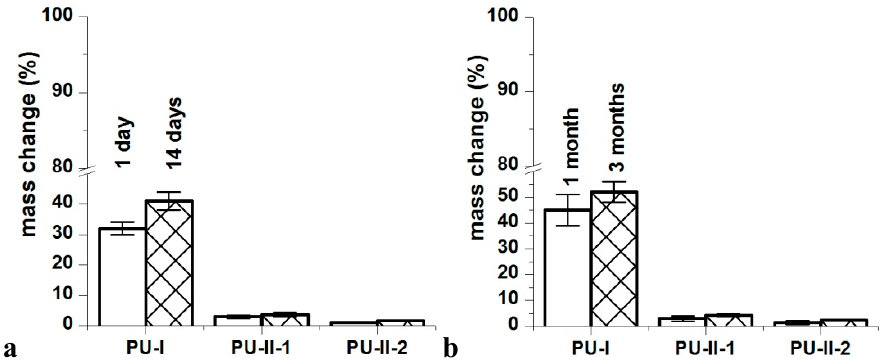
a b Figure 5. Distilled water ( a ) and PBS ( b ) sorption of obtained PURs after selected incubation time-points.